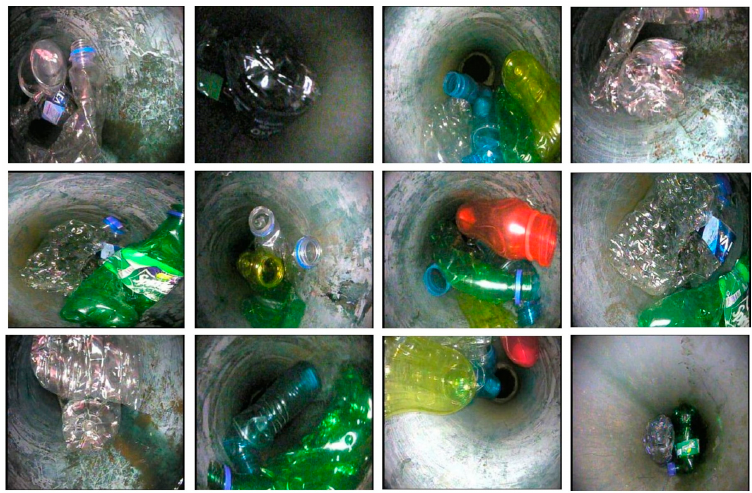
Figure 5. Tree root blockage frames in the S-BIRD dataset.